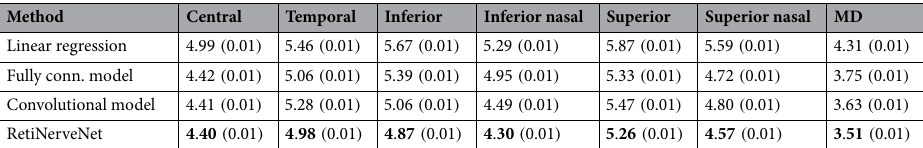
Table 3. Average MAE (with standard errors) for sectoral averages and mean deviation estimation. Best results in boldface.